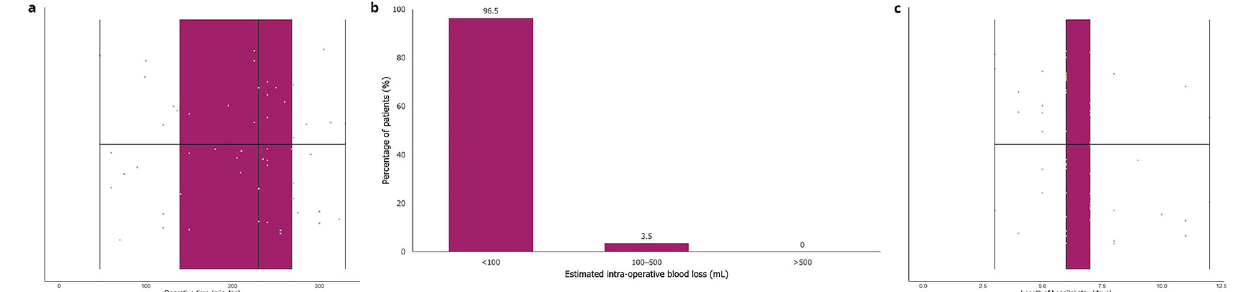
Figure 3. Outcomes of robot-assisted TTE. Operative time from first incision to skin closure ( a ); estimated intra-operative blood loss ( b ); and number of days from operation to discharge ( c ). For ( a ) and ( c ), the middle vertical lines represent the medians, left and right box edges represent the first and third quartiles, and the lower and upper whiskers extend to the respective lowest and highest